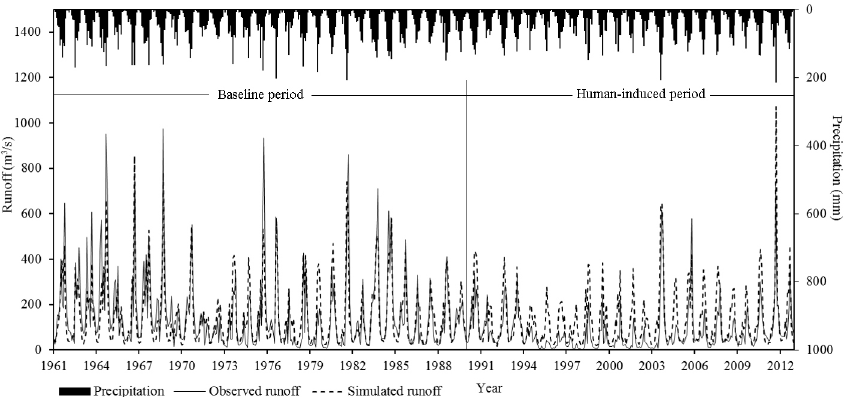
Figure 3. Monthly observed and VIC-simulated runoff for baseline (1961–1990) and human-induced (1991–2012) period at the Xianyang hydrologic station.